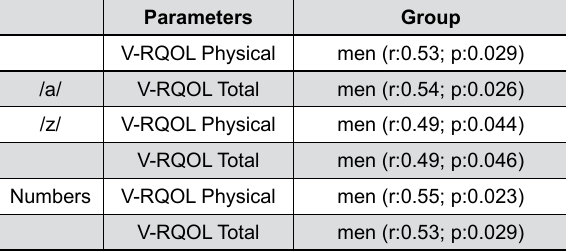
Figure 2- Significant correlations of MPT with V-RQOL Protocol. No correlation of the spirometry data with the V-RQOL protocol was observed.